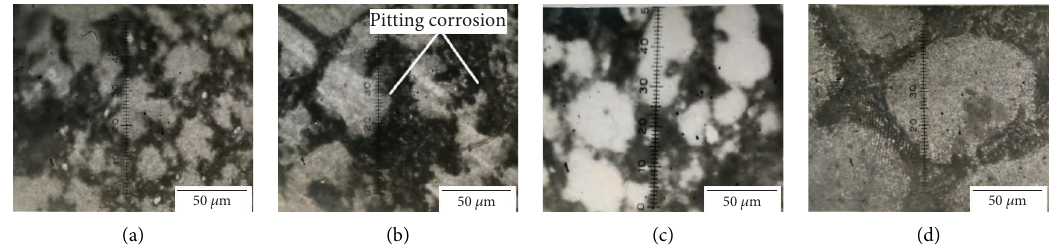
Figure 10: Optical micrograph of corroded joints after PWHT: (a) ST; (b) AA; (c) STA; and (d) BM.